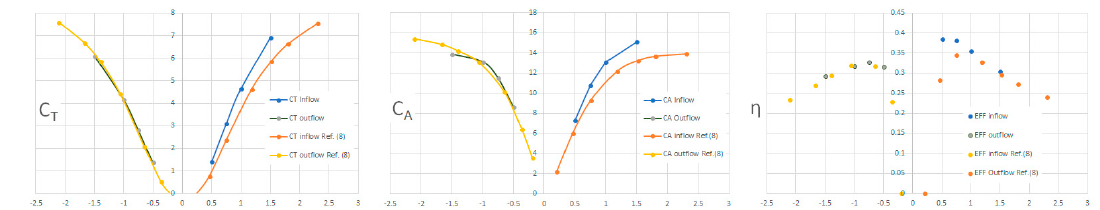
Figure 5. Performance criteria for M16 geometry with 25° setting